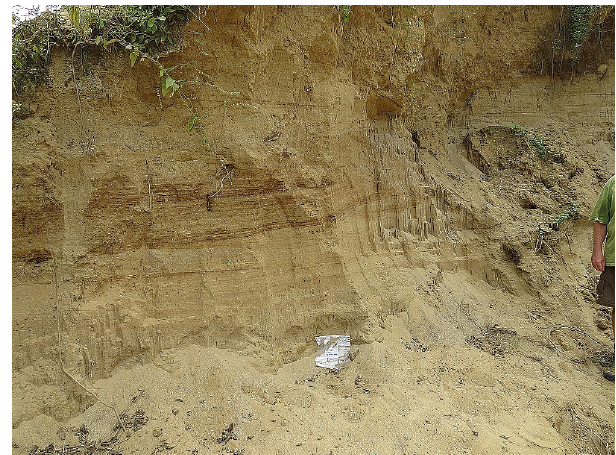
Figure A11. NGM – cross-bedded sand succession ∼ 17m above modern channel. Sample was taken from base of 1.5m thick cross- bedded sand unit. Top of unit (S2) OSL dated at 7200 ± 2000 years by Sinha et al. (2010).